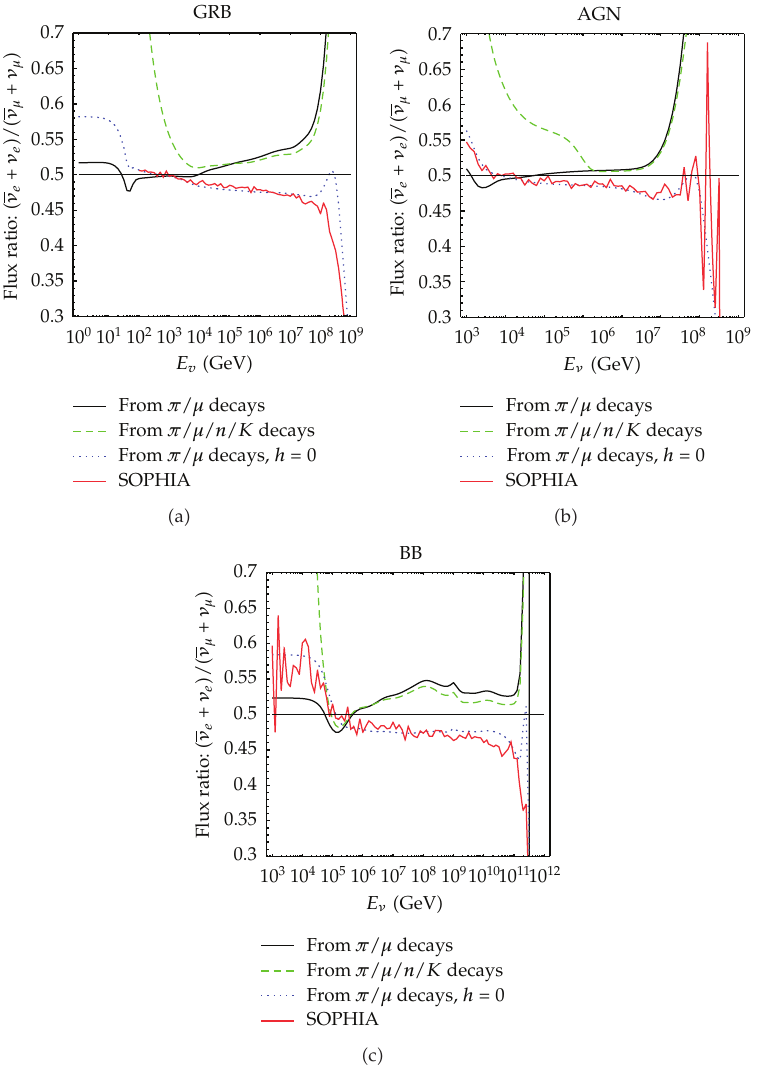
Figure 2: Flux ratio at the source between electron and muon neutrinos as a function of the neutrino